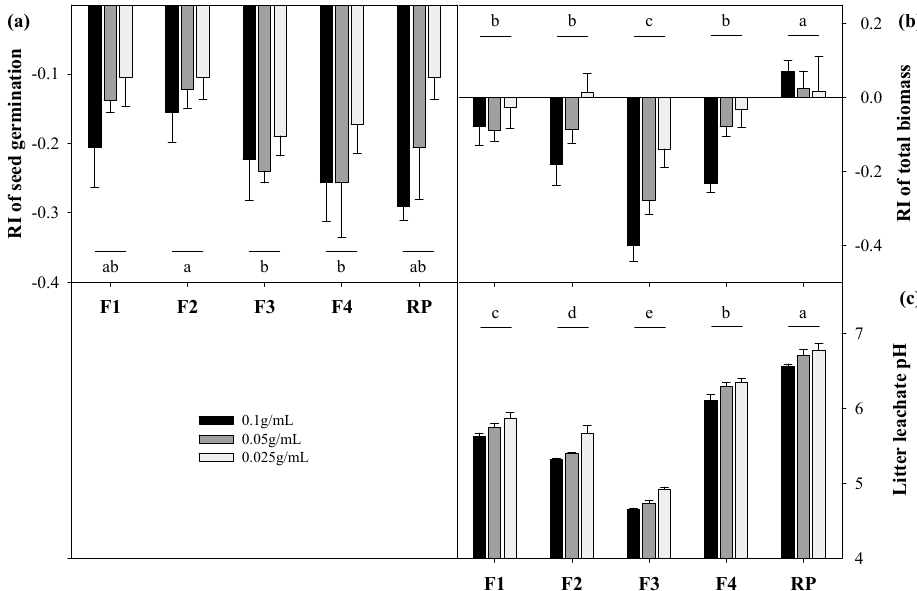
Figure 3. Effects of litter leachates on ( a ) seed germination, ( b ) biomass accumulation of Phytolacca americana and ( c ) the pH of the litter leachate. RI was used to evaluate the allelopathic effects of forest litter. RI > 0 indicates a positive effect, RI < 0 indicates an inhibitory effect, and RI = 0 indicates no effect. The absolute value of RI indicates the intensity of the effect. Statistically significant differences ( P < 0.05) among 5 forest types (F1: Pinus densiflora forest, F2: Pinus densiflora+Quercus acutissima mixed forest, F3: Quercus acutissima forest, F4: Deciduous broadleaved mixed forest, and RP: Robinia pseudoacacia plantation) are denoted by different letters.